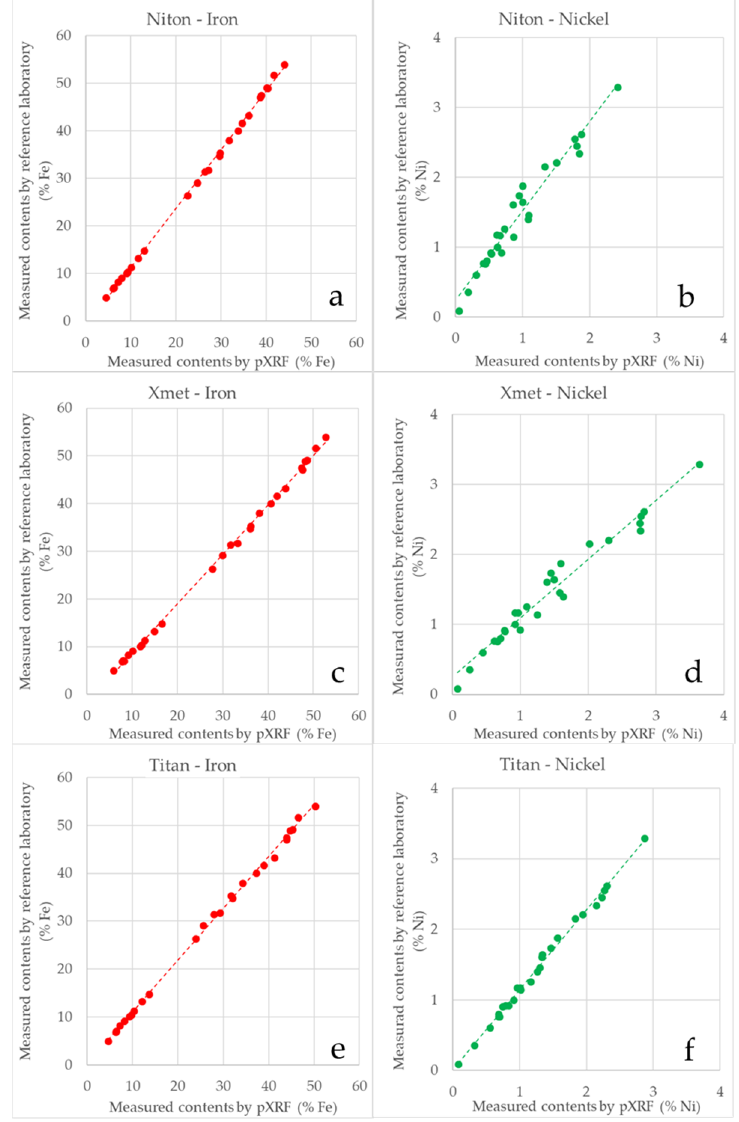
Figure 7. Linear regression for Fe and Ni in the three devices used for measuring: ( a , b ) Niton, ( c , d ) Xmet and ( e , f ) Titan.